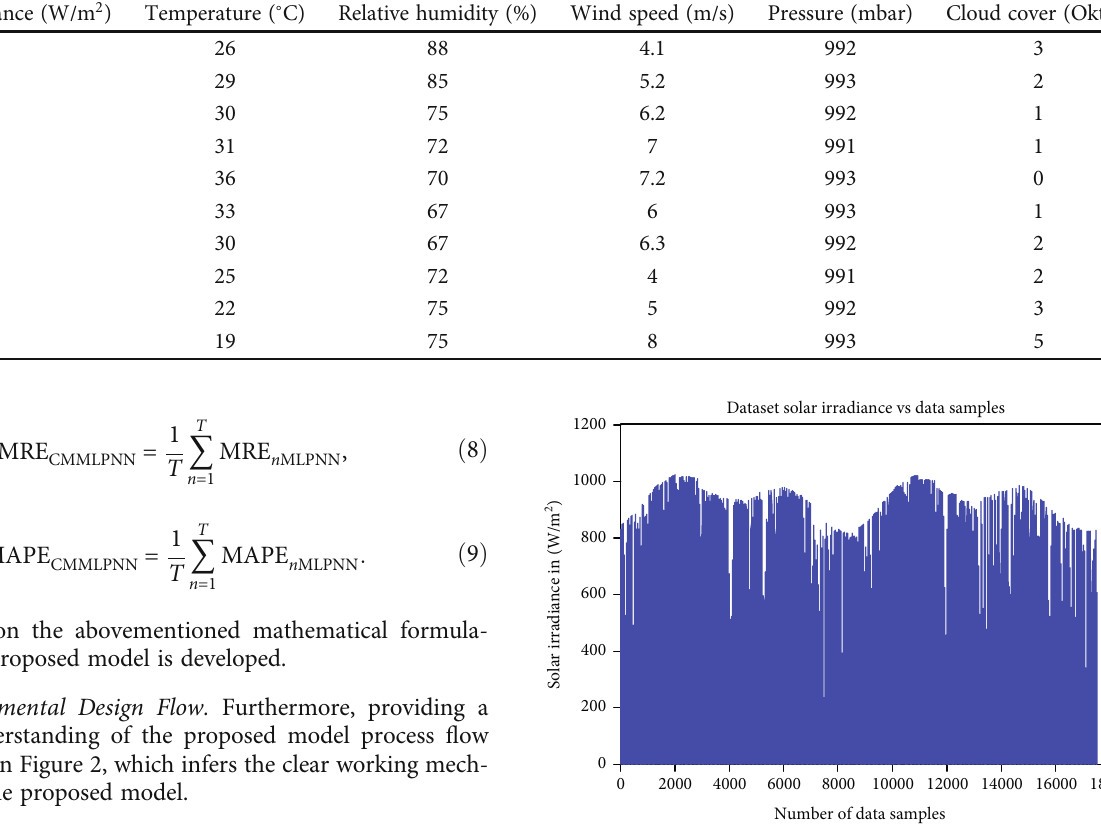
Figure 3: Acquired dataset solar irradiance vs. data